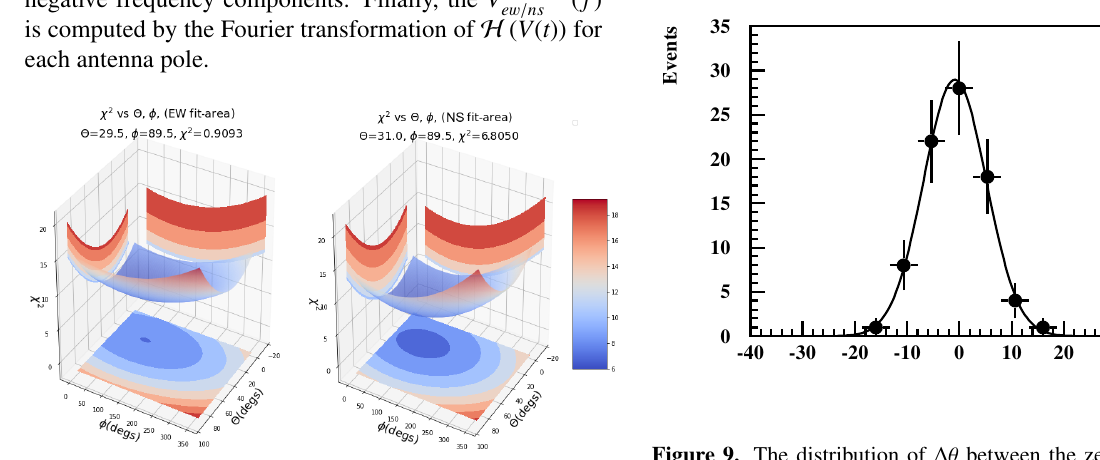
Figure 7. χ 2 as a function of θ,φ for EW and NS polarization for a cosmic event. The direction of this event using the particle detetor data is estimated to be θ = 30 o and φ = 93 0 .